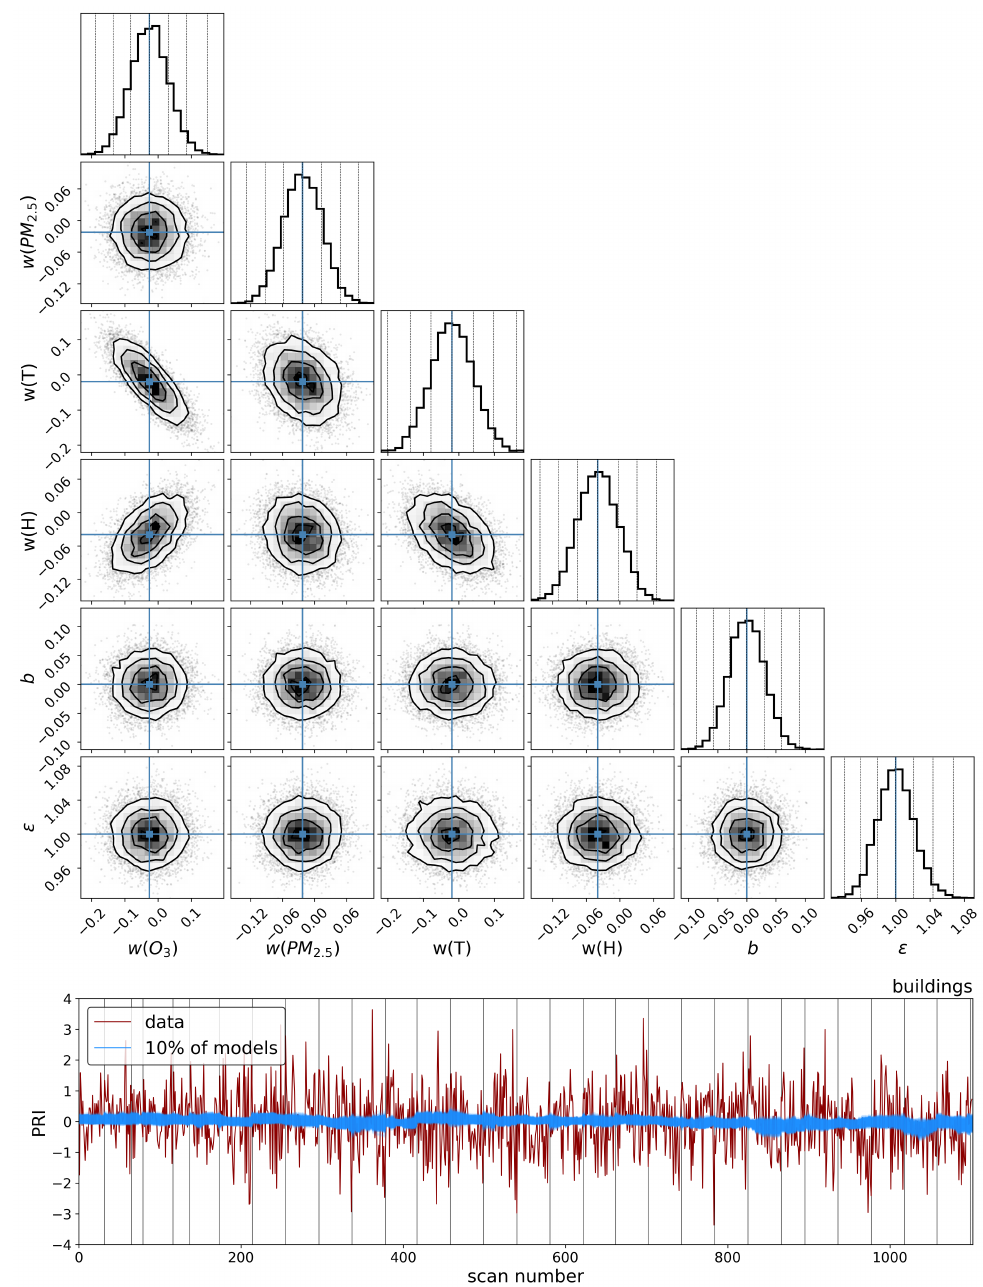
Figure A4. MCMC corner plot of posterior distribution for PRI of the